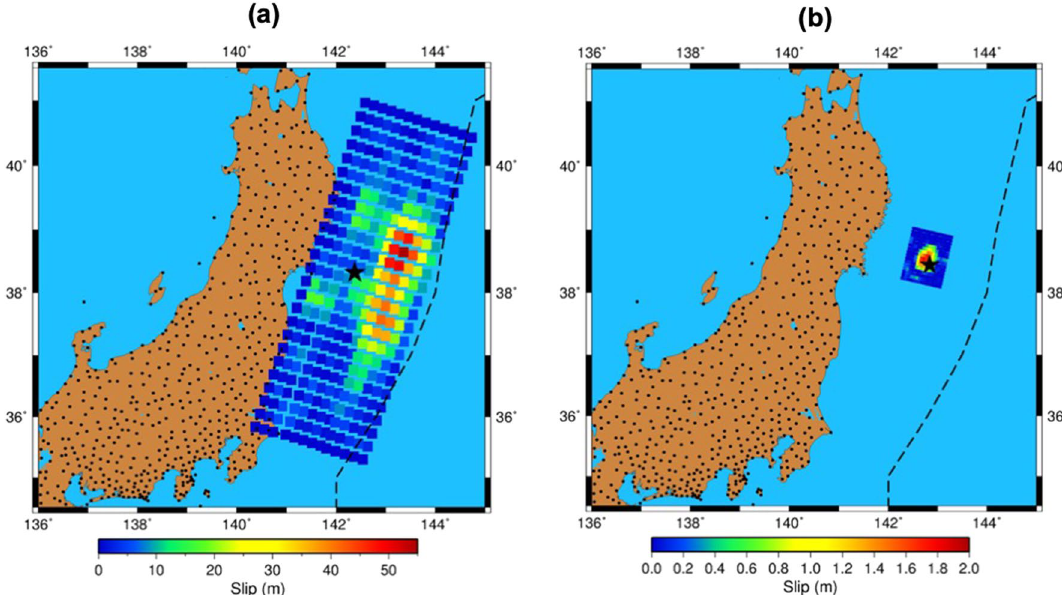
Figure 5. Maps for the Mw9.0 Tohoku earthquake of 11 March 2011 ( a ) and the M7.3 Sanriku earthquake of 9 March 2011 ( b ). Black star shows the epicenter, black dots show GPS receivers, and the colored squares depict corresponding color scale is shown on the bottom. The dotted curve shows the position of the Japan Trench. The maps were plotted by using GMT6 software 48